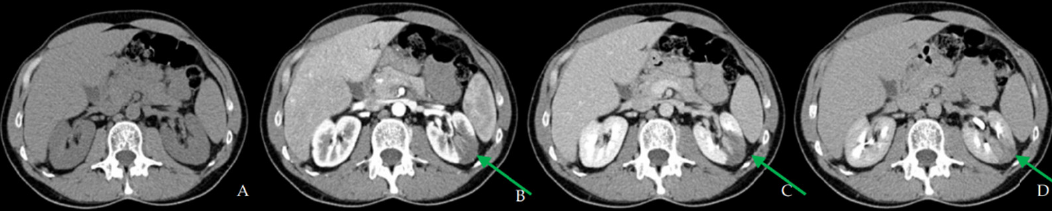
Figure 1. CT scan performed at first admission (( A ) basal; ( B ) arterial phase; ( C ) venous phase; ( D ) urographic phase) shows an ischemic hypodense area in the upper-middle third of the left kidney (green arrows).